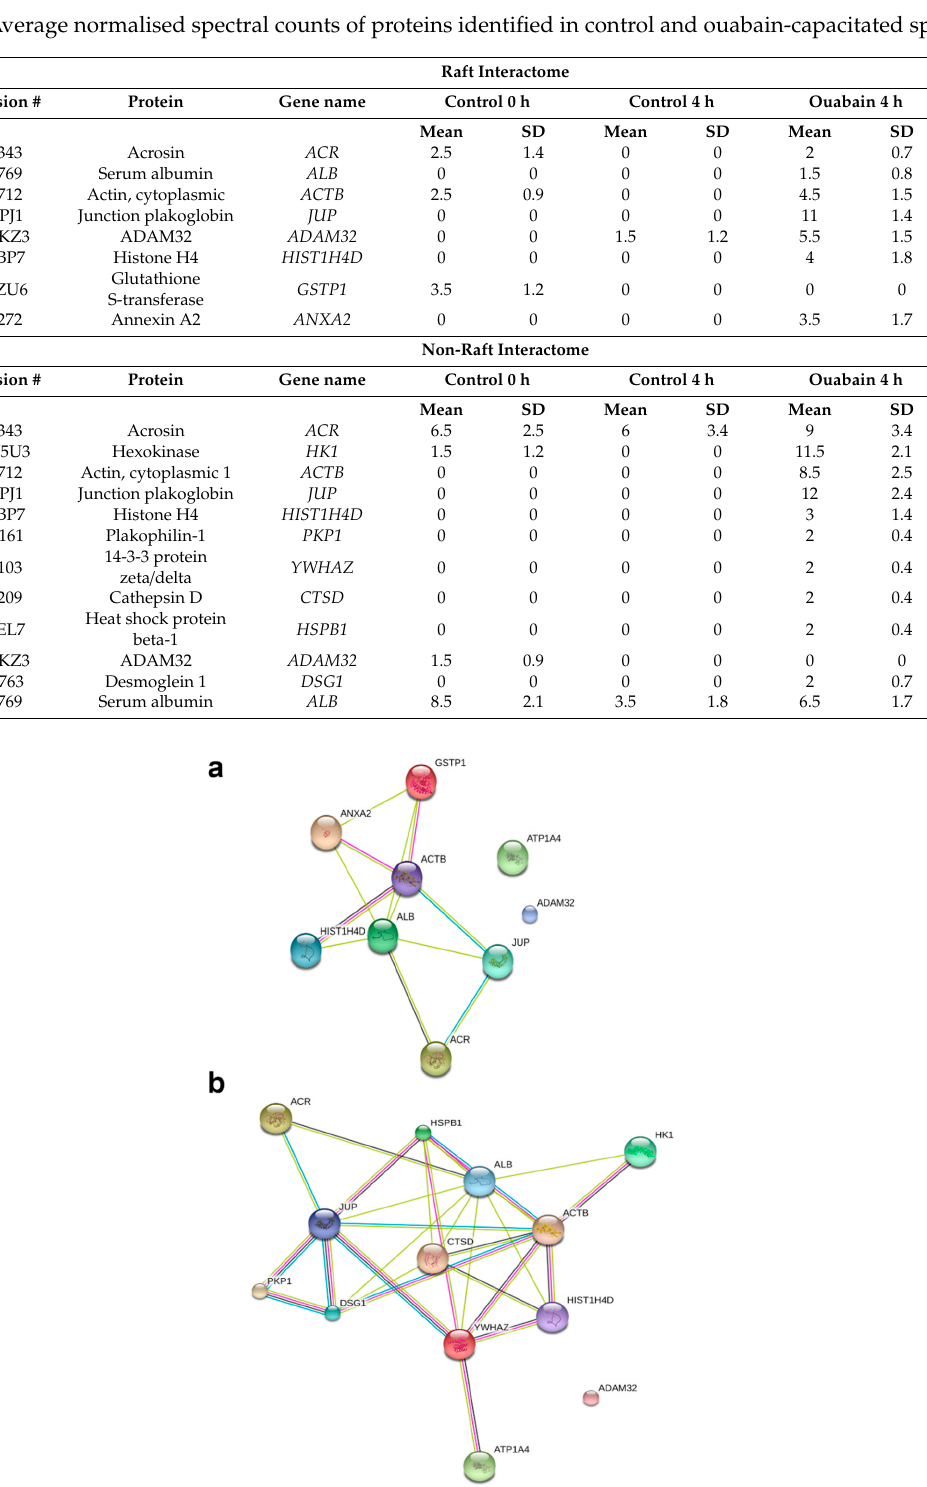
Figure 4. Protein–protein interaction (PPI) analysis using STRING. ( a ) and ( b ) represent PPI network analyses from raft and non-raft fractions, respectively, based on evidence and confidence level. More interconnecting lines indicate a strong evidence for PPI and different colours indicate the source of evidence between interacting proteins. For example, black line represents co-expression studies; pink line denotes experimentally determined interactions; green line suggests curated databases; and blue line suggests literature mining. The proteins identified in raft and non-raft fraction clusters are shown in Table 1.